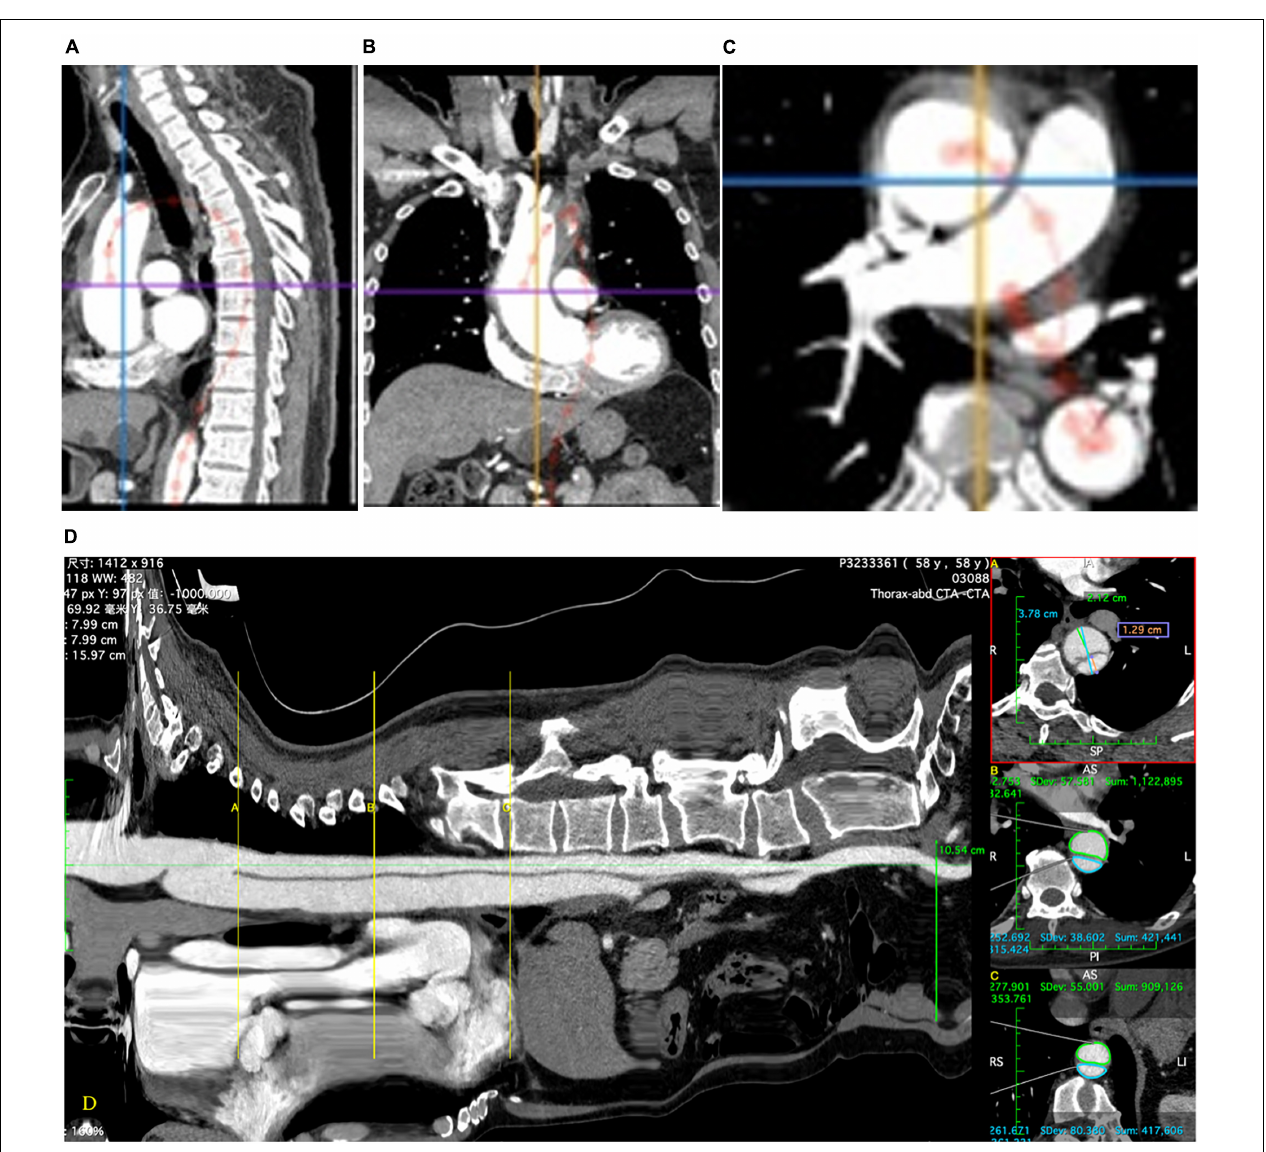
FIGURE 1 | The central luminal line is installed which allows a “stretch view” to be produced (D) . This allows accurate determination of anatomic landmarks and precise location of measurements. Diameters (A) and areas (B,C) are measured using multiplanar reconstructions of the computed tomographic images in the plane perpendicular to the central luminal line using the appropriate measurement tools (D)